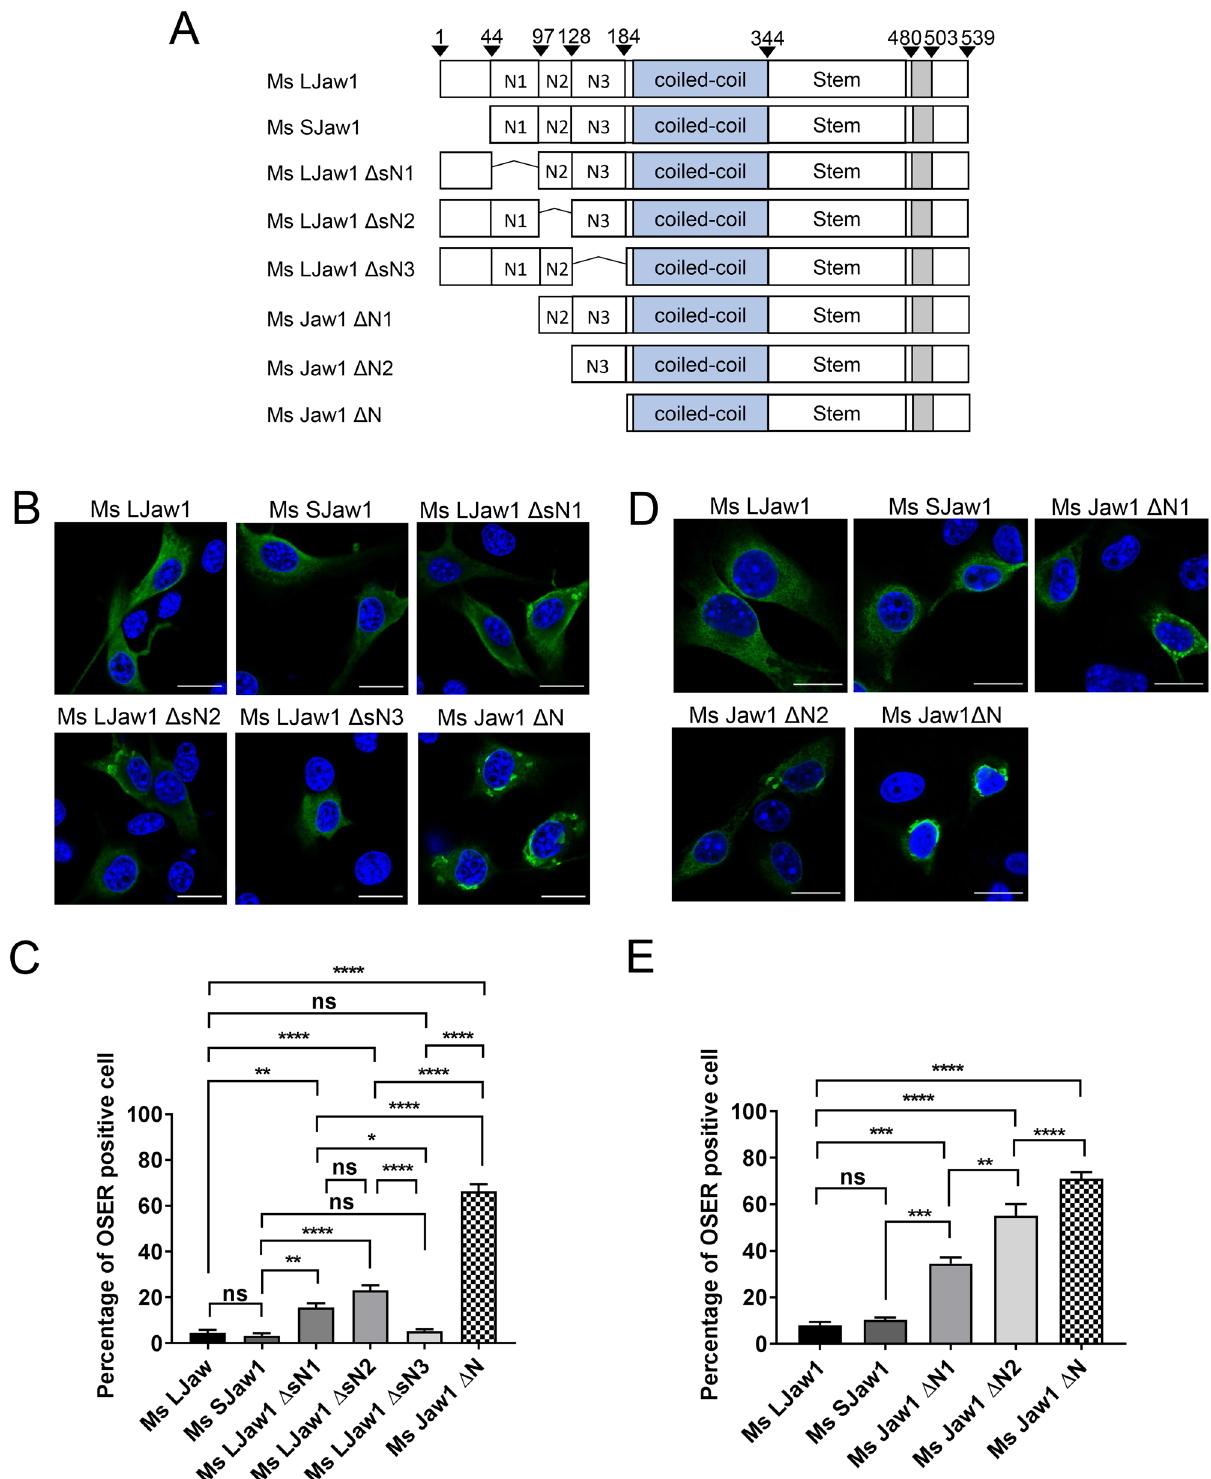
Figure 3. Exploration of the specific N-terminal region involved with the inhibition of OSER formation. ( A ) Schematic representation of Mouse Jaw1s or deletion mutants lacking the limited N-terminal region (Ms LJaw1 ΔsN1, Ms LJaw1 ΔsN2 and Ms LJaw1 ΔsN3) and deletion mutants with N-terminal regions of different lengths (Ms Jaw1 ΔN1, Ms Jaw1 ΔN2 and Ms Jaw1 ΔN). ( B , D ) Ms LJaw1, Ms SJaw1, Ms LJaw1 ΔsN1, Ms LJaw1 ΔsN2, Ms LJaw1 ΔsN3 or Ms Jaw1 ΔN ( B ) and Ms LJaw1, Ms SJaw1, Ms Jaw1 ΔN1, Ms Jaw1 ΔN2 or Ms Jaw1 ΔN ( D ) were expressed in B16F10 cells by transfection. After incubation for 24 h, immunostaining was performed using an anti-Jaw1 rat antibody (green). Nuclei were stained with Hoechst33342 (blue). The images were acquired by confocal microscopy. Scale bar; 20 μm. ( C , E ) Counting of the cells having OSER structures out of the Jaw1 positive cells in ( B , D ) (n = 100). In the graph, the percentage of cells with OSER structures is shown based on the average of four independent experiments per condition. Error bars show the S. D. “ns”, not significant; * P < 0.05; ** P < 0.01; *** P < 0.001; **** P < 0.0001, Turkey Kramer’s t